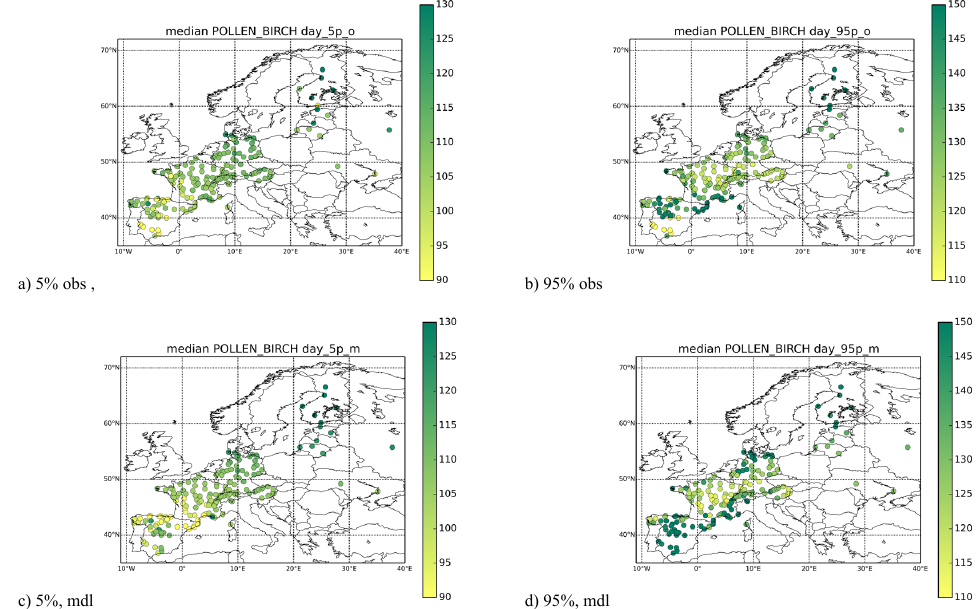
Figure 6. Start ( a, c , date of 5% of the cumulative seasonal total) and end ( b, d , date of 95% of the cumulative seasonal total) of the 2013 pollen season (Julian days), observed (a, b) and predicted by the ensemble median (c, d) .